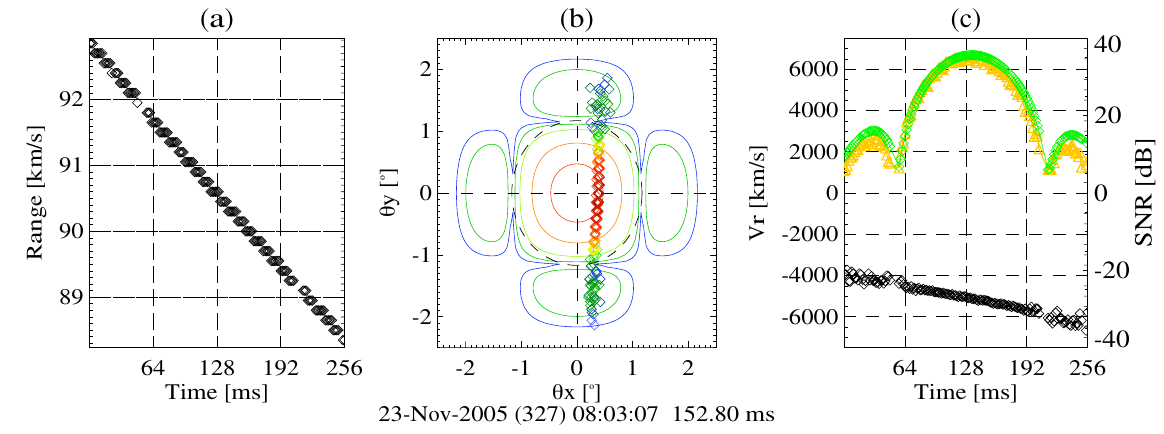
Fig. 4. Example of a meteor-head echo observed at Jicamarca. (a) Range vs. time, (b) θ x vs. θ y , and (c) radial velocity vs. time and SNR vs. time. The theoretical antenna pattern is indicated in panel (b) for different levels in dB. In panel (c) the measured SNR is indicated in yellow, while the expected relative SNR based on the antenna pattern and angle information, is denoted in